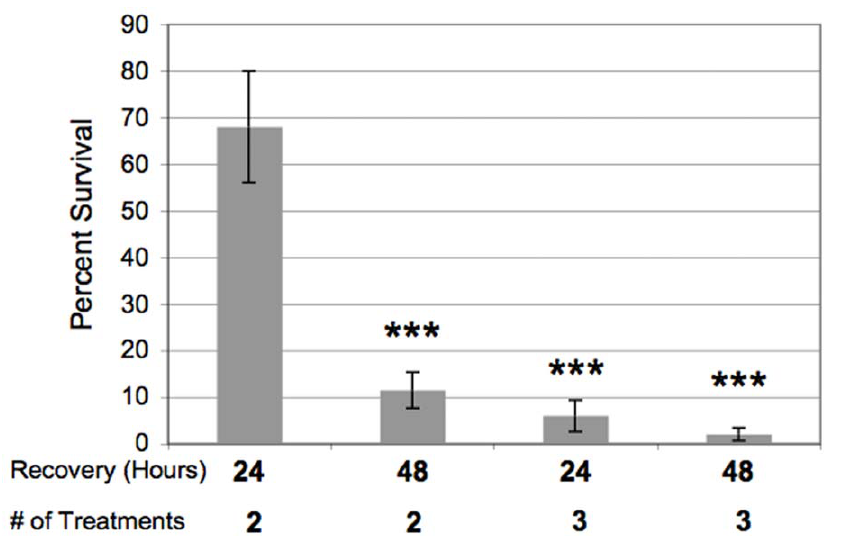
Figure 1. Tubercidin-loaded erythrocytes are toxic to E.histolytica . Trophozoites were exposed to tubercidin-loaded erythrocytes two or three times ( # of Treatments) and viability was assessed 24 hours or 48 hours after treatment. The data are reported as a percent of the starting number of viable amoebae before treatment. The data represent the mean 6 S.D of $ 3 trials (*** P , 0.001). Three treatments of E. histolytica cells with tubercidin-charged hRBCs resulted in the death of nearly 100% of the cells 48 hours after application of selection.